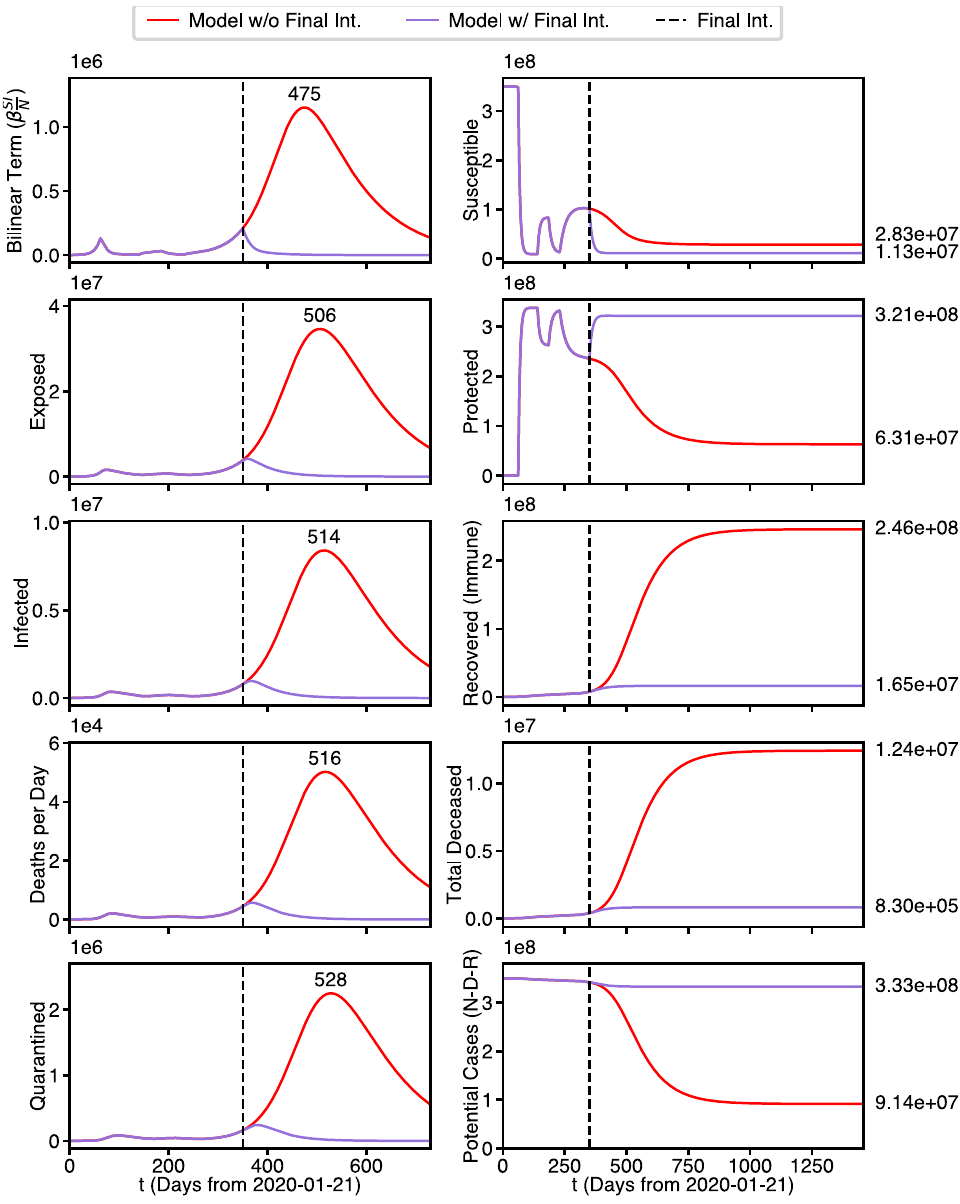
Figure 4. Four year predicted state population waveforms. Best fit parameters with and without final